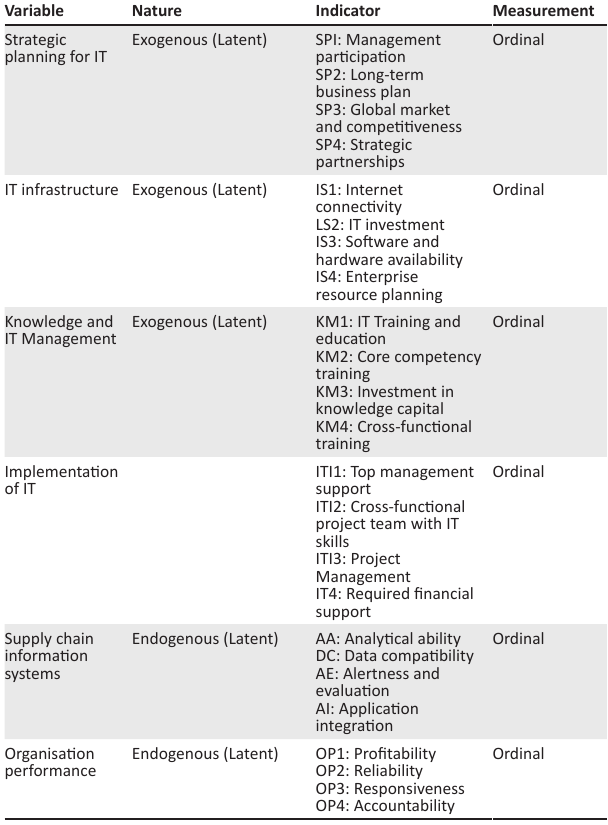
TABLE 1 : Variable definition and